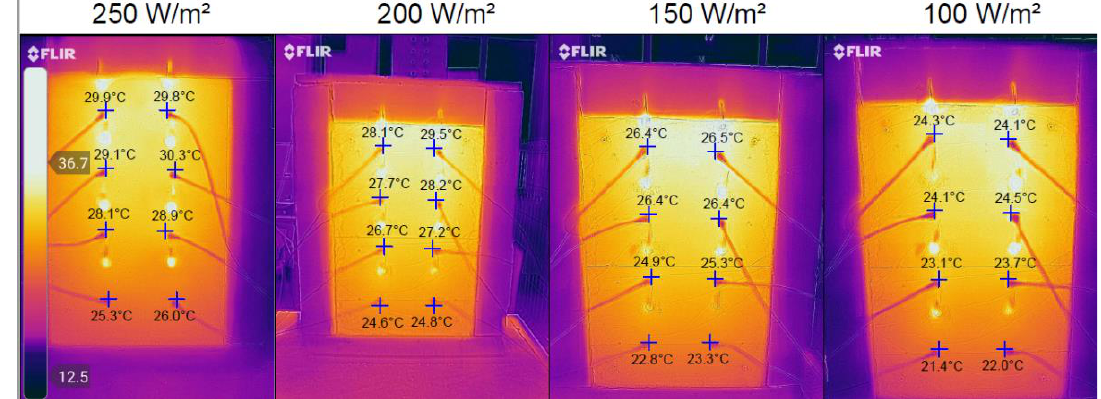
Figure 9. Infrared camera photos for CW02.